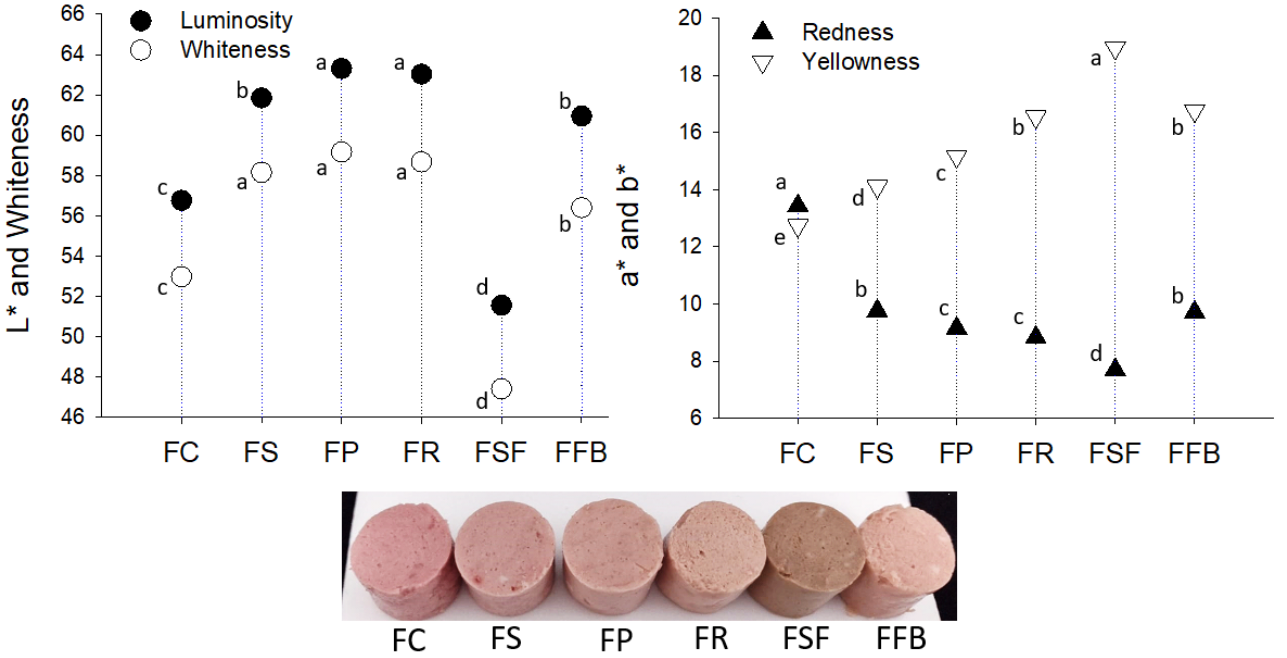
Figure 1. Instrumental color parameters of hybrid meat emulsions elaborated with plant proteins as partial meat substitutes. Mean values with different letters on the column differ from each other ( p ≤ 0.05 ) according to the post hoc Tukey ’ s test (a* and b* coordinates) and Games- Howell’s test (L* coordinate and Whiteness). FC: control; FS: soy; FP: pea; FR: rice; FSF: sunflower; FFB: fava bean.